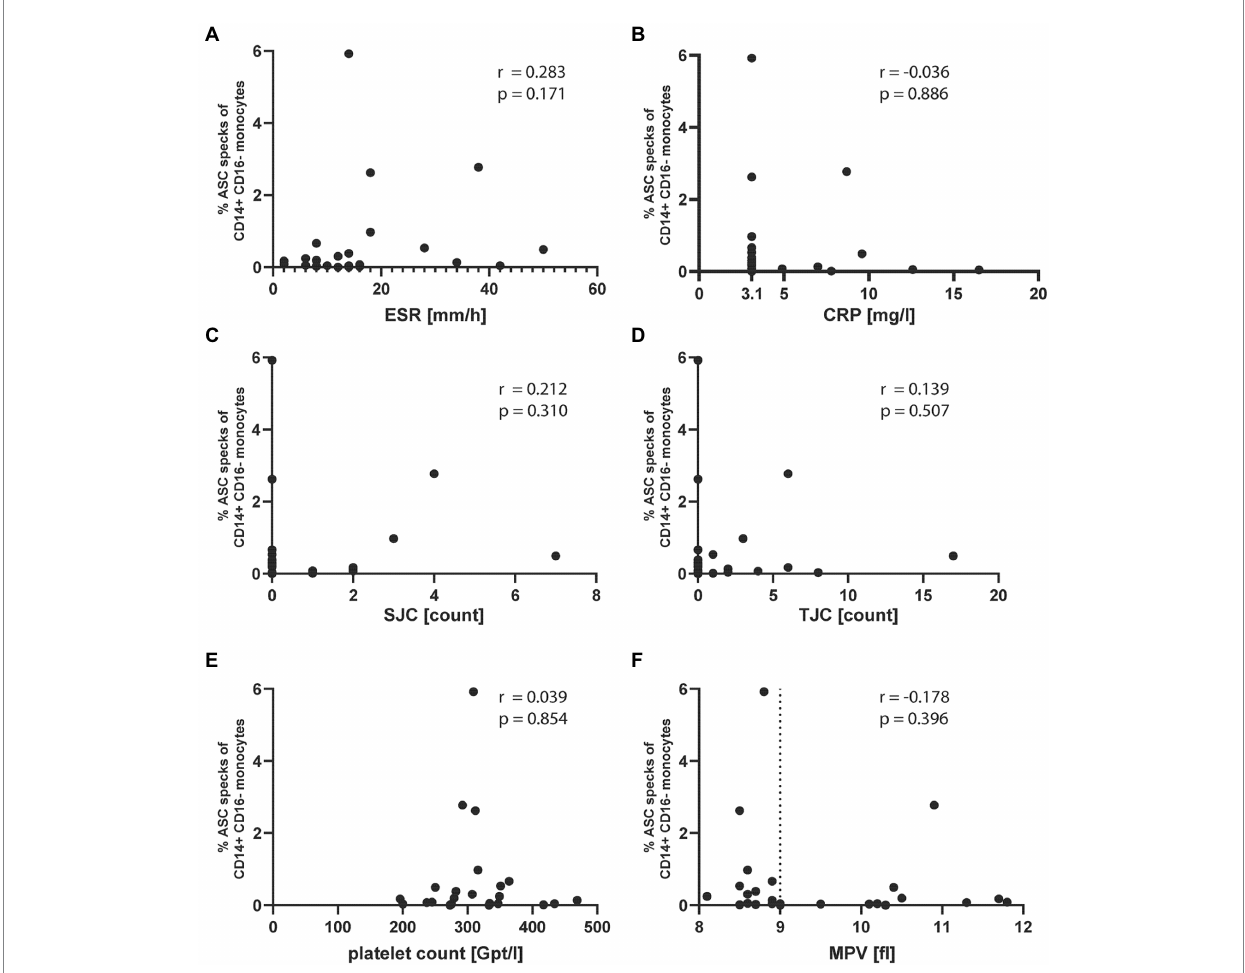
FIGURE 2 ASC specks in oligo-articular JIA patients do not correlate with common inflammatory markers or platelet count and size. Correlation of % ASC speck + CD14 + CD16 − monocytes in oligo-articular JIA patients with (A) ESR, (B) CRP, (C) SJC, (D) TJC, (E) platelet count, or (F) MPV. Spearman r correlation, a p -value p < 0.05 was considered